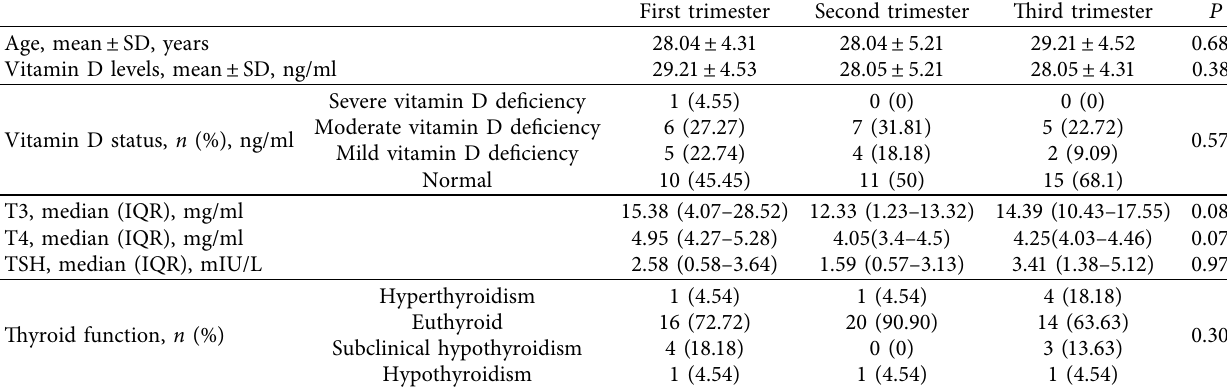
Table 1: Studied population characteristics in different trimesters.